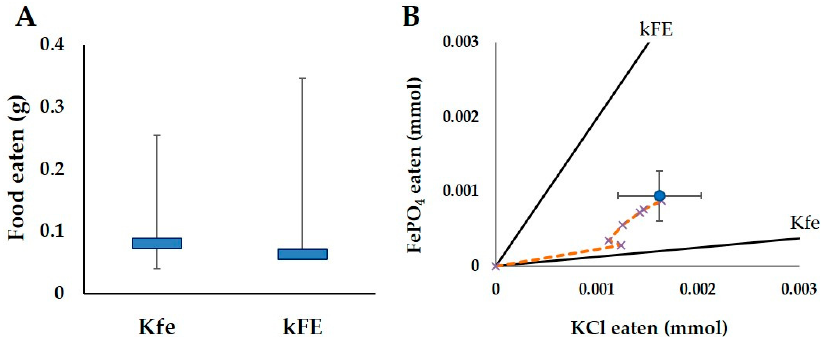
Figure 2. Results of the feeding trial in termites exposed to the food varying in KCl and FePO 4 (Kfe and kFE). ( A ) Medians (blue bar) and quartiles (error bars) of the total amount of food eaten for all colonies (N = 10) after 14 days; ( B ) The nutritional intake of the termites for KCl and FePO 4 over the 14 d period. The large blue circle with error bars indicates the average total intake of KCl and FePO 4 for all colonies. The small x’s indicate the average cumulative intake per day (including day 0) for all colonies and are connected by the orange dashed line to represent the average intake trajectory. The black lines represent the nutrient rails, the ratio of FePO 4 and KCl in each diet (Kfe and kFE). These rails represent the intake trajectory if the termites were to exclusively feed on that diet. The closer the feeding trajectory is to a rail, the more similar the nutrient intake was to the diet represented by that rail.